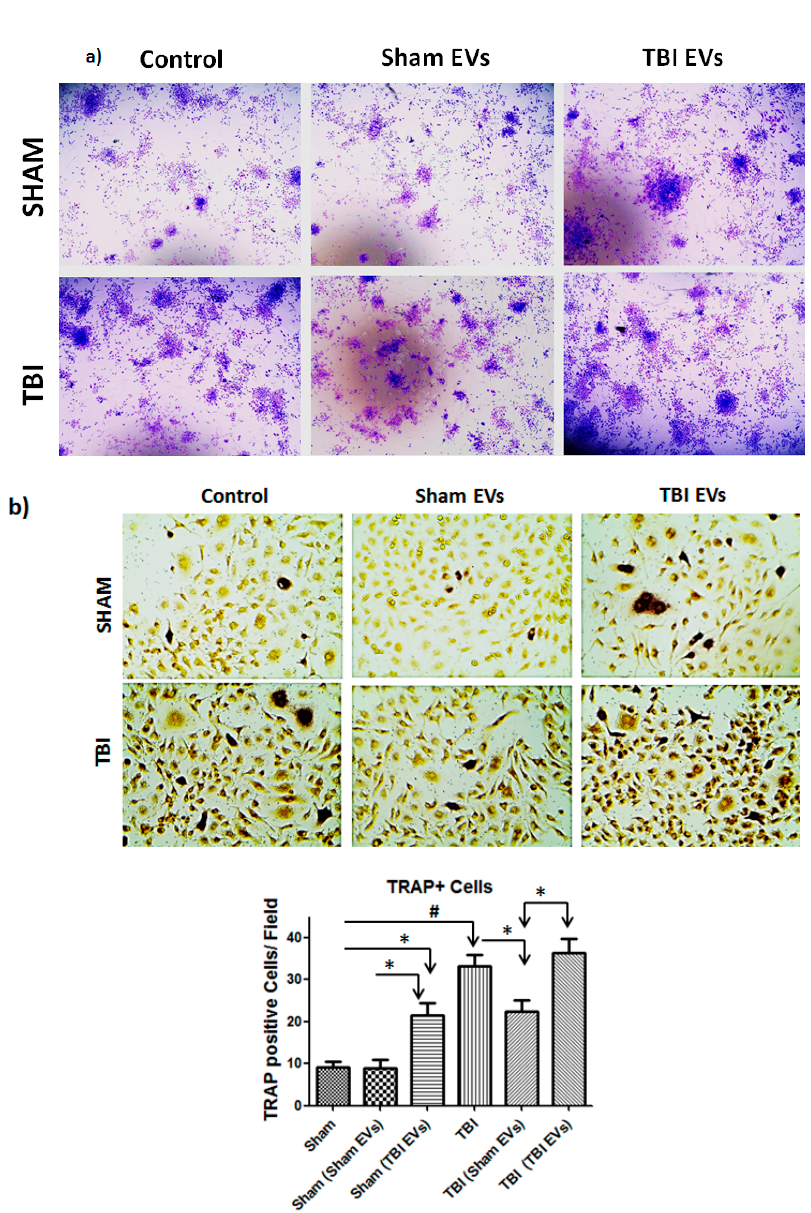
Figure 7. Effect of bone marrow derived EVs from TBI on colony forming unit (CFU) and osteoclast differentiation of bone marrow cells. ( a ) Colony forming assay were performed with M-CSF (30 ng/mL) in the presence or absence of sham/TBI derived EVs for 4 days, stained with crystal violet staining, and colonies were counted. ( b ) Mouse primary bone marrow cells were cultured with RANKL (100 ng/mL) and M-CSF (30 ng/mL) in the presence or absence of sham/TBI derived EVs for 6 days followed by TRAP staining. After TRAP staining, TRAP + multinuclear cells (TRAP + MNCs) with more than three nuclei were scored as osteoclasts (Significant * p < 0.01, # p < 0.001).